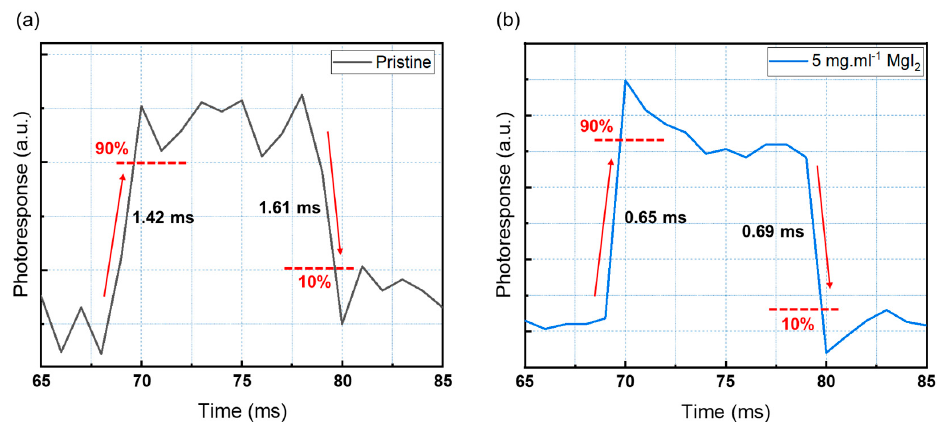
Figure 6. Rise and decay time of the ( a ) pristine device and ( b ) modified device. Table 2. Summary of the response time of different inorganic-based perovskite photodetectors. Photodetector Structure